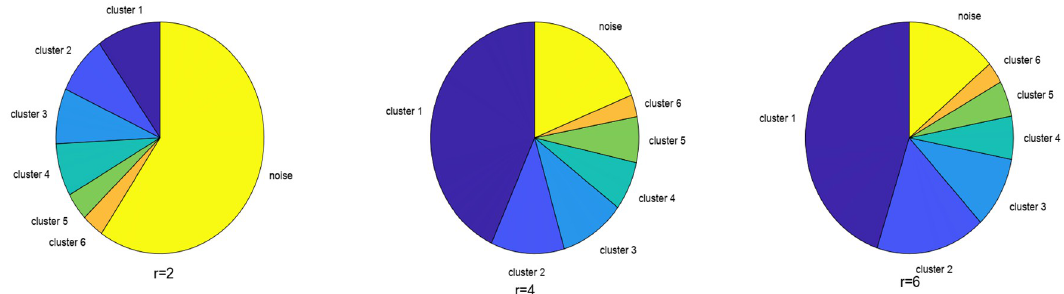
Fig 7. The proportions of clusters and noises under the different values of r . When r is set to be 2, most of the load curves are excluded from the six major clusters, that is, normal load curves are wrongly recognized as noise. When r is set to be 6, cluster 2 are composed of two types of different load curves, that is, the time tolerance is too high to divide clusters properly. r = 4 makes a trade- off between the mentioned